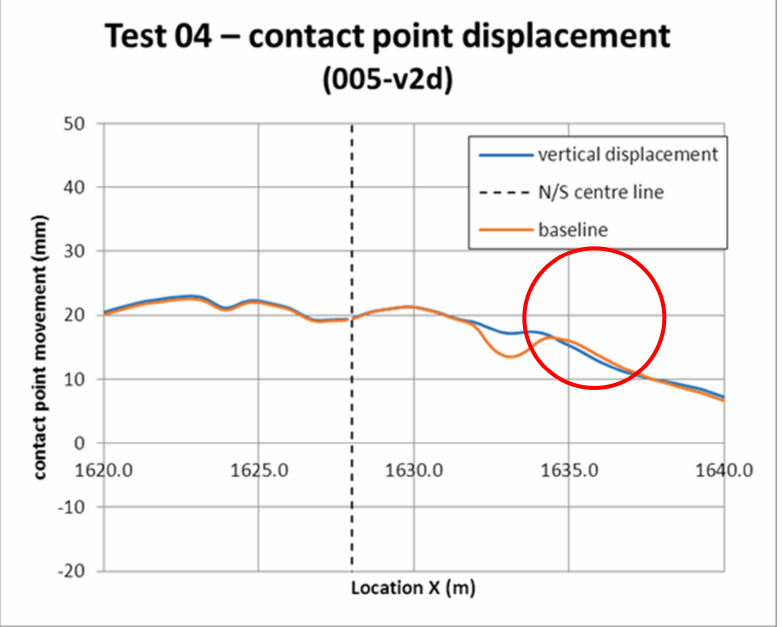
Figure 19. Exit lever arm option vertical displacement compared to baseline, showing much improved profile at exit of neutral section